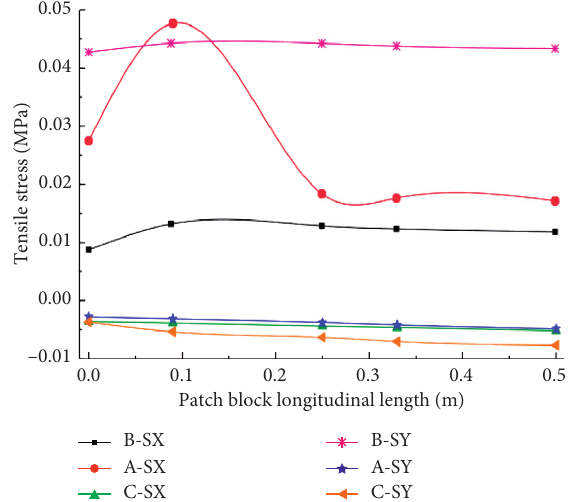
Figure 7: The effects of longitudinal movement of different loading positions on tensile stress of joint filling